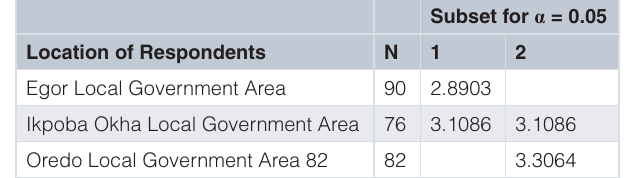
Table 9.1. Post Hock Tests (Homogeneous